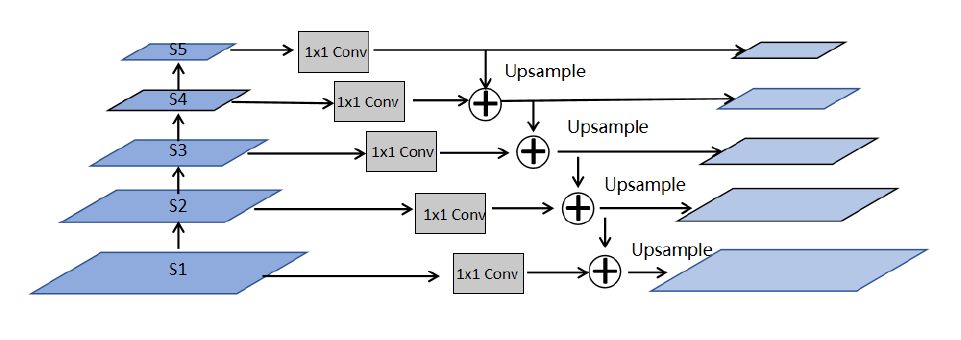
Figure 3. The structure of the feature pyramid network